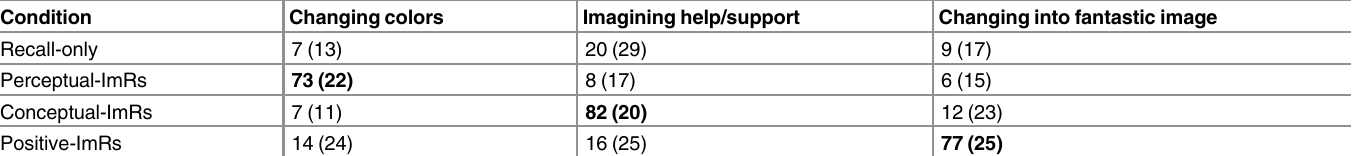
Table 4. Means (SD) of task compliance measures per condition (in mm). Condition-relevant task ratings are in